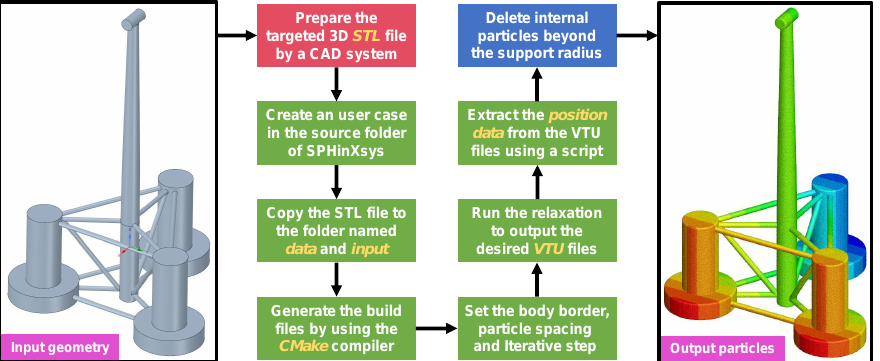
Figure 5. The pipeline of CAD-BPG: an example for generating the body-fitted and uniformly distributed particles of a semi-submersible